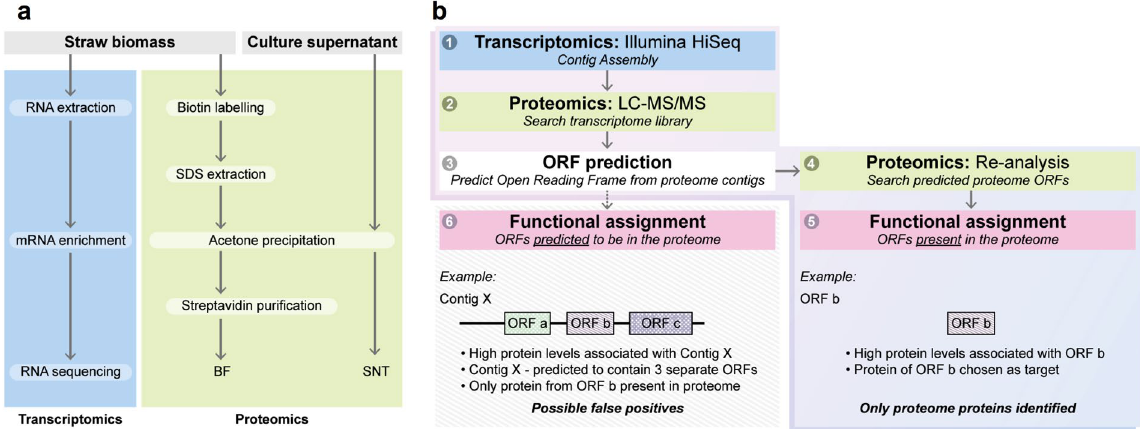
Figure 1. Experimental overview and data analysis of a combined metatranscriptomic and metaproteomic approach to identify unique protein pools in microbial composting communities. ( a ) The experimental overview is split into two sections. For transcriptomic analysis, RNA was extracted from straw biomass and enriched before being sequenced by Illumina HiSeq. For proteomic analysis, soluble protein was precipitated from culture supernatant (SNT), washed and resolublized before analysis, while proteins bound to the straw biomass were first labelled with a sulfo-NHS-SS-biotin tag before solubilizing with a stringent SDS wash (biotin labelled fraction, BF). After precipitation, washing and resolubilization, biotinylated proteins were purified using streptavidin sepharose media. Protein samples were then analysed by LC-MS/MS. ( b ) For data analysis we used the generated metatranscriptomes (1) to identify proteins observed in the various fractions as follows: tandem mass spectra of proteins observed by LC-MS/MS were matched to contigs (2) from the metatranscriptomic analysis, and open reading frame (ORF) predictions were made from these contigs (3). These putative proteomic ORF libraries were used for a second round of analysis of the original LC-MS/MS tandem mass spectra (4). By performing this re-analysis with the putative proteomic ORFs, we only identified proteins that are seen at the protein level (5) and avoided false positives that may have arisen from tandem mass spectral matches to multi-ORF contigs